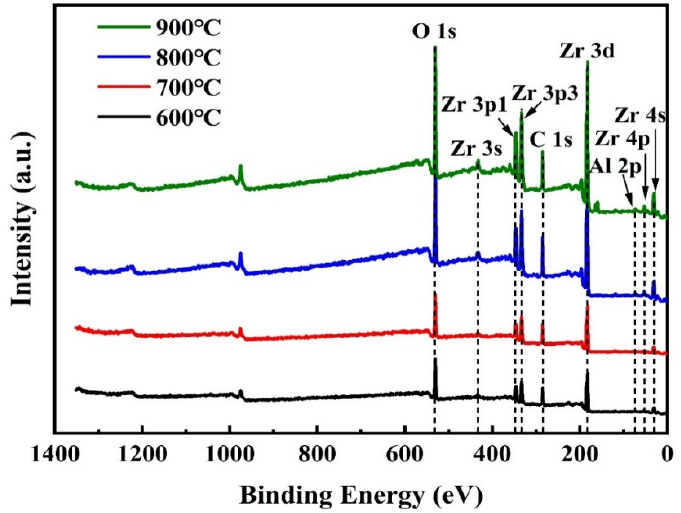
Figure 3. XPS full spectrum of AZO films at different annealing temperatures.